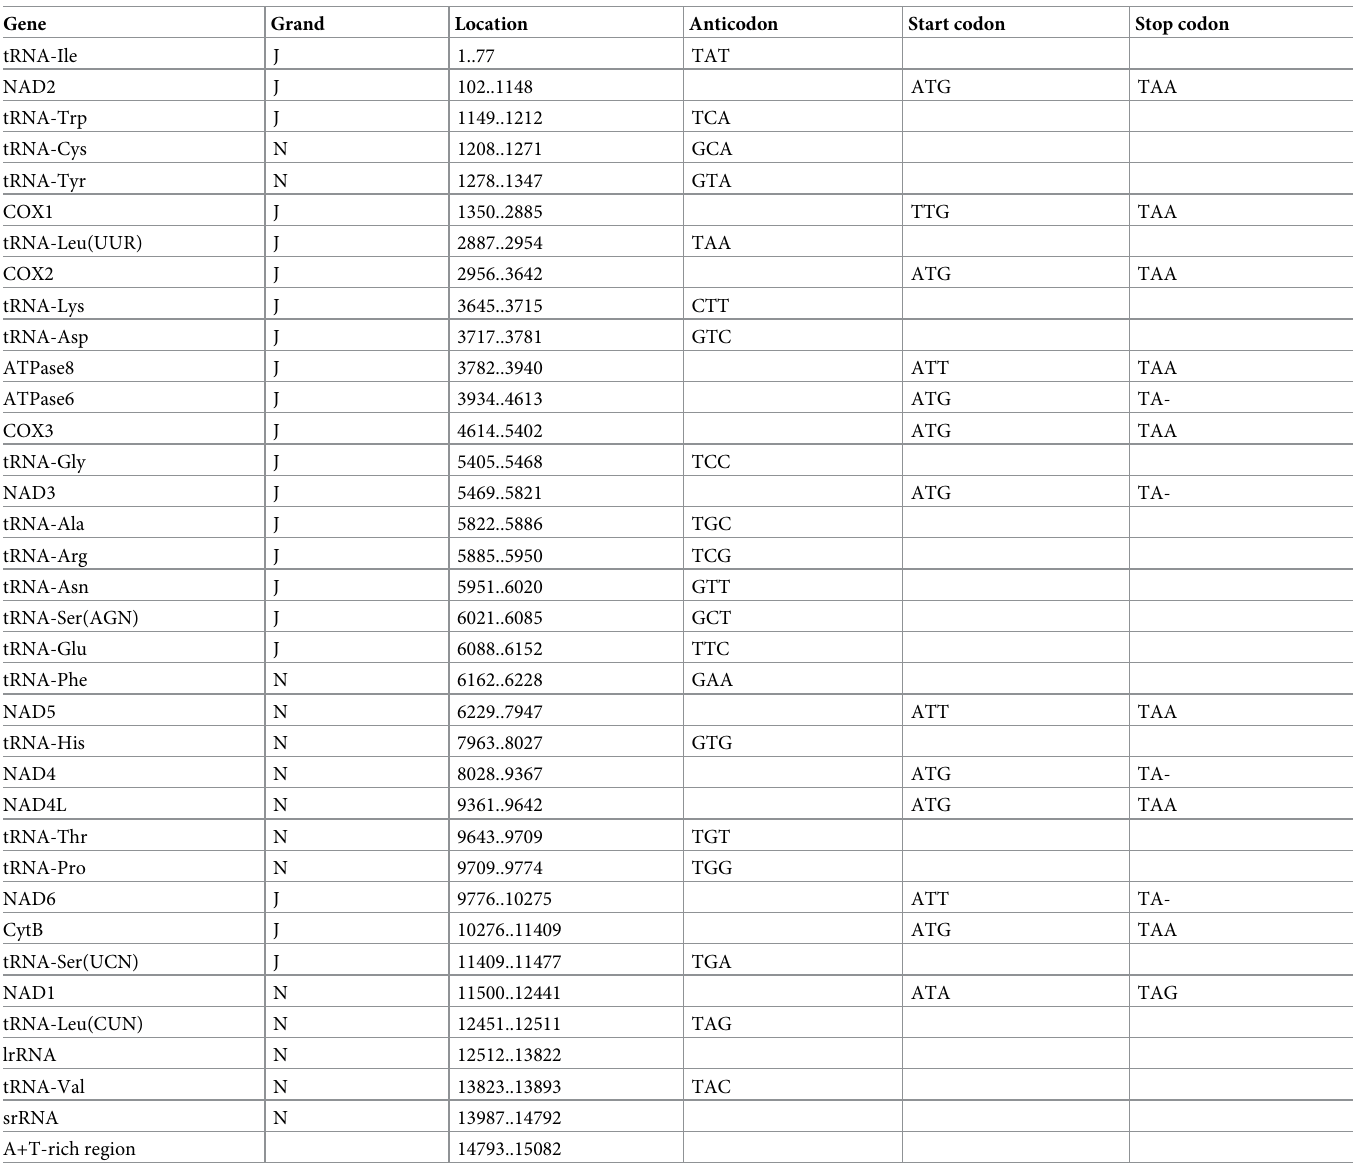
Table 3. Annotation of Episymploce splendens